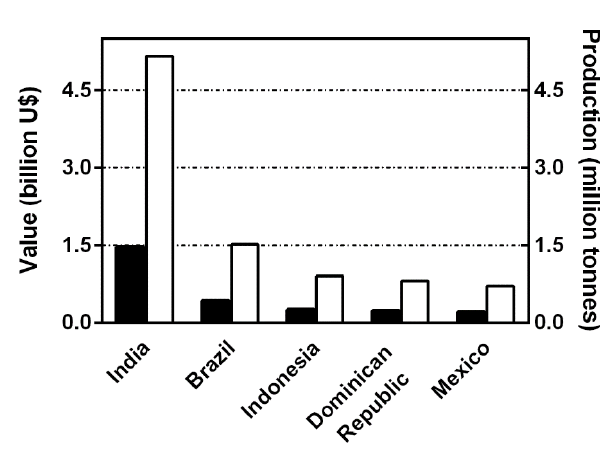
Figure 1. The graph represents the five highest papaya producing countries in 2012. Solid bars correspond to revenue of billions of US dollars and open bars, production in million